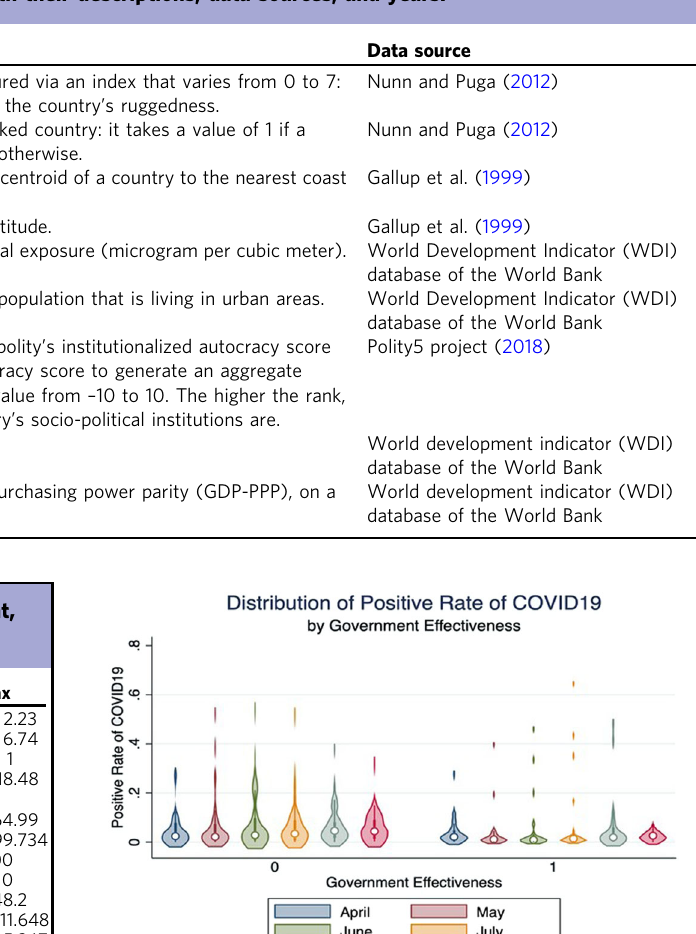
Table 1 List of the control variables used in the study with their descriptions, data sources, and years.